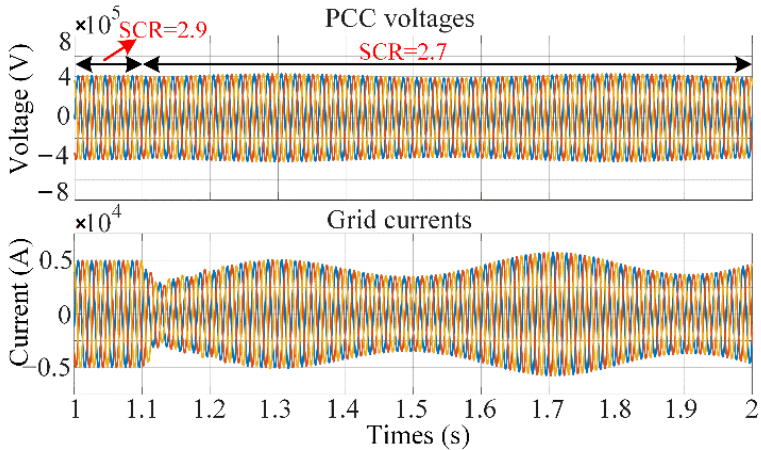
Figure 18. Simulation results of the grid-connected MMC with PLL dynamics. For this case, the DC-voltage control is added in the case of MMC considering PLL dynamics. Figure 19 shows the effect of DC-bus voltage control on the MMC admittance. It can be seen that the DC-bus voltage control mainly affects the admittance responses of MMC below 10 Hz. Considering that adding DC voltage control hardly changes the the same as the stability analysis considering PLL dynamics. Therefore, the condition for considering the coupling is the same as that of MMC considering the PLL dynamics, which is not analyzed in